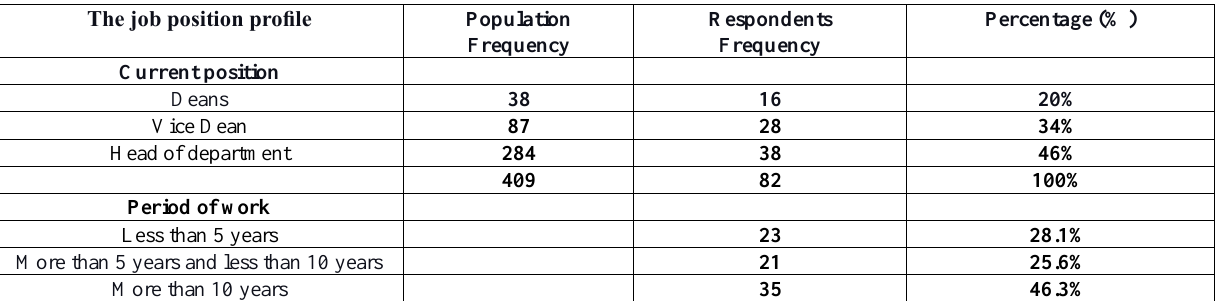
Table 2. The Job Position Profile of Participants